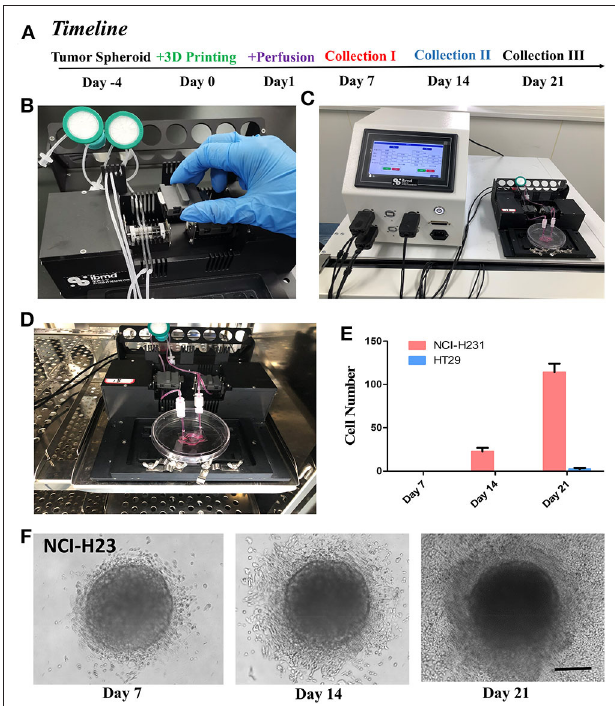
FIGURE 6 | Perfusion of the tumor-on-a-chip and study of cancer invasion and metastasis. (A) The timeline of the experiment with the cancer spheroid containing flow microchip for cancer invasion and metastasis study. (B) The setup of peristatic pumping system. Each chip has two channels for inlet and out perfusion. (C) The controller of the perfusion system, allowed automated perfusion of chip. (D) The microchip and entire circulation system were setup in incubator, and perfused at 0.2 ml/min for up to 21 days with three times of sampling procedures and medium changes. (E) Cell metastasized and harvested from cancer spheroids from the perfusion medium on day 7, 14, and 21. (F) NCI-H23 cell in the L-G-C composite hydrogel with in Day 7, 14, and 21. Cells had distinguished invasion into the 3D-Matrix and migrated out of the gel into the micro-channels. N = 3 for each experiment. Error bars indicate the S.E.M of the data variation. Scale bar: 200 µ